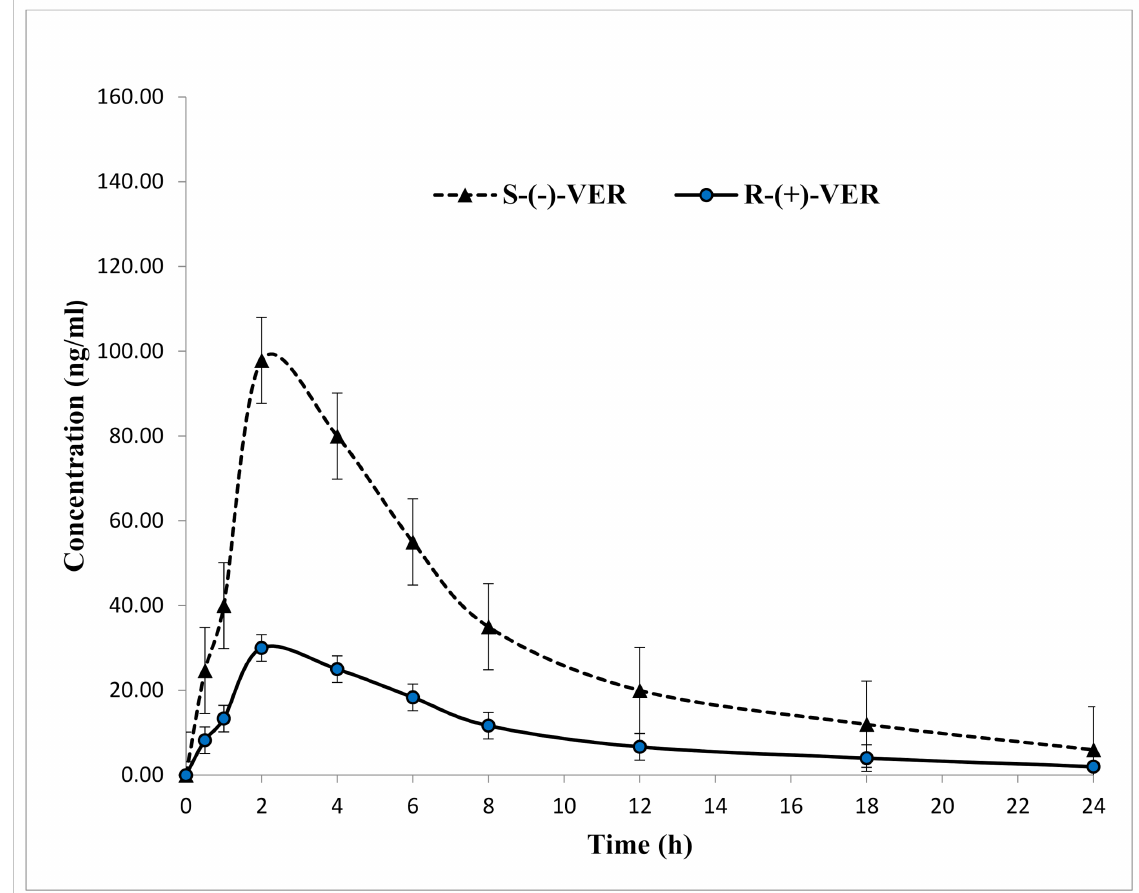
Figure 4. Mean plasma concentration-time profile of S-( − )- and R-(+)-verapamil after oral (gavage) administration of 10 mg/kg racemic verapamil hydrochloride to Sprague-Dawley rats, ( n = 6, mean ± SD). Table 7. The enantioselective pharmacokinetic parameters of S-( − )- and R-(+)-verapamil in